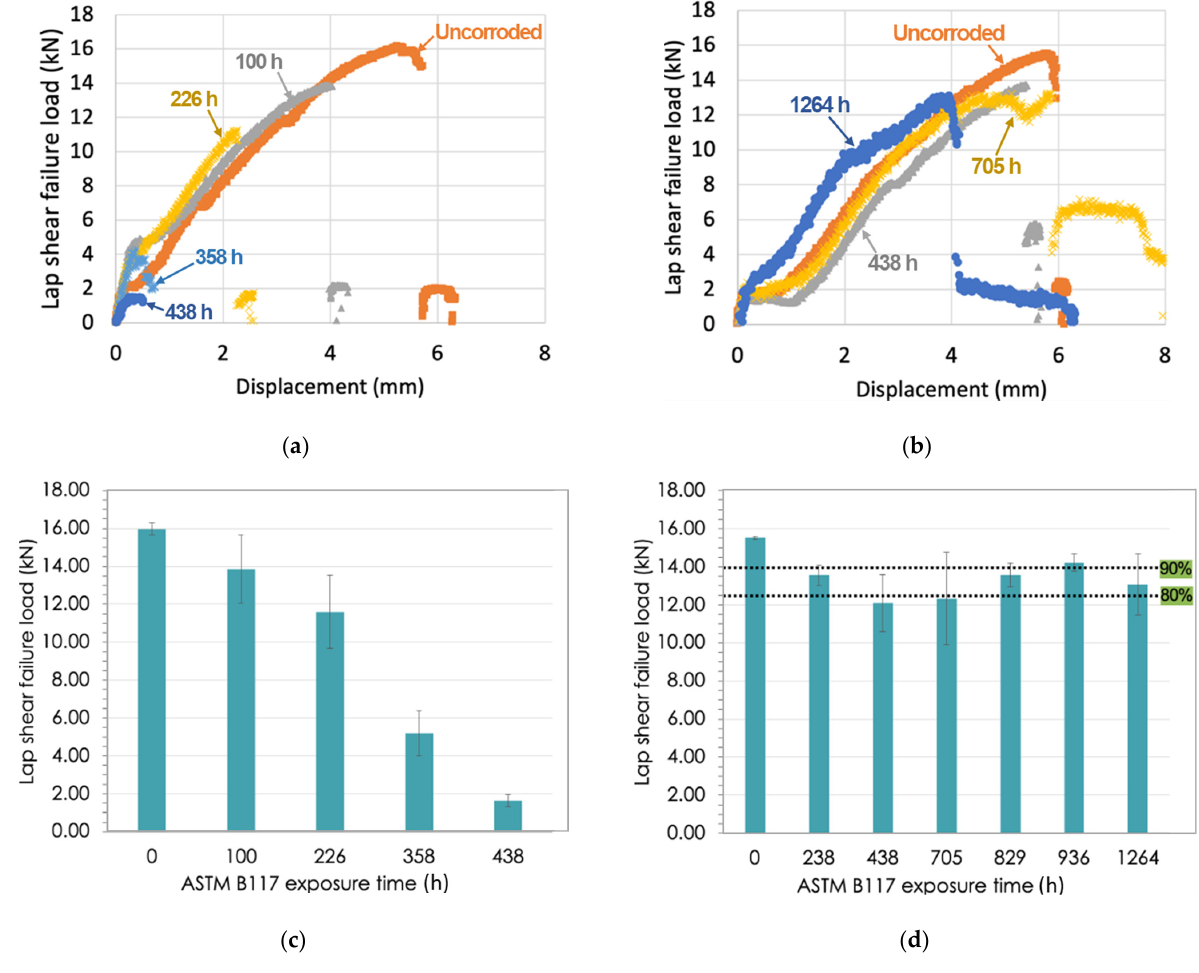
Figure 9. Representative load and displacement curves from lap shear tensile testing for ( a ) bare and ( b ) polymer-insulated bolted CFRC-AZ31B joints with different ASTM B117 exposure times. The average values of lap shear peak failure load are presented for ( c ) bare and ( d ) polymer-insulated bolted joints with the different exposure times.